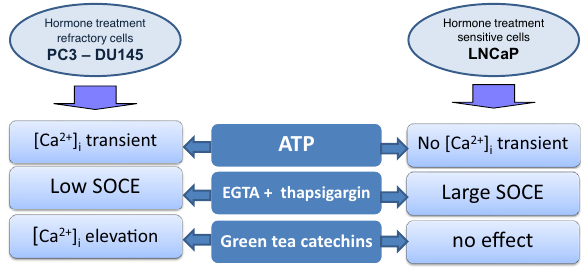
Figure 5: The three main di ff erences in Ca 2 + signaling between hor - mone treatment refractory and sensitive cells: response to purinergic stimulation, [ Ca 2 + ] i storing and releasing capacity and sensitivity to GTE